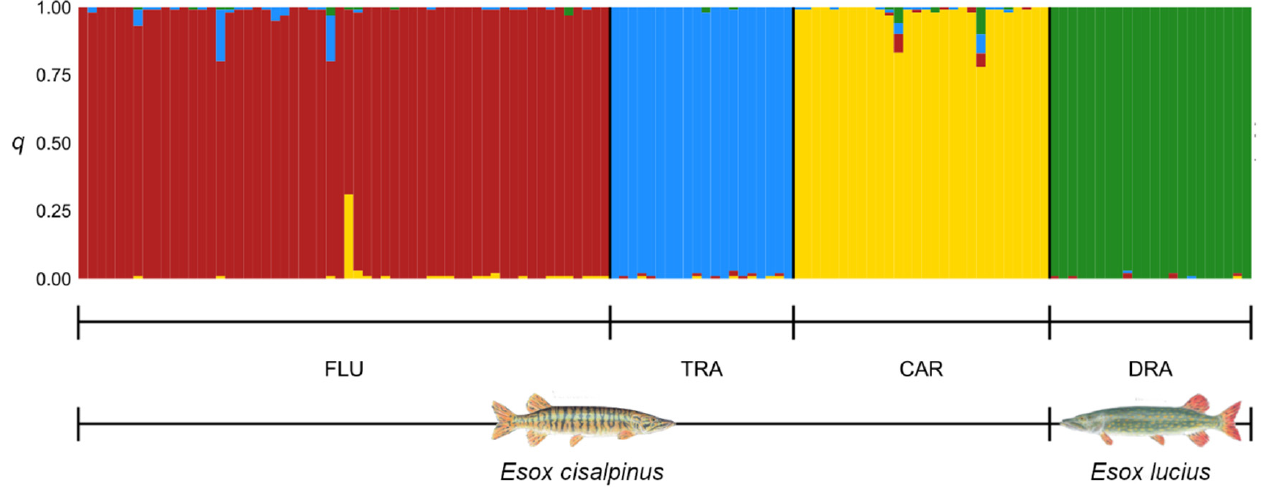
Figure 2. Most likely genetic structure inferred by Bayesian model-based clustering. The model with K = 4 ( K = number of genetic clusters) was selected out of models in which K ranged from 1 to 7 by both Evanno et al.’s and Puechmaille’s methods [52,53]. Each individual is represented by a thin vertical bar, which is partitioned into K -coloured segments. The height of each segment is proportional to the individual membership coefficient ( q ) in the corresponding cluster. Populations are abbreviated as in Figure 1 and Table 1.